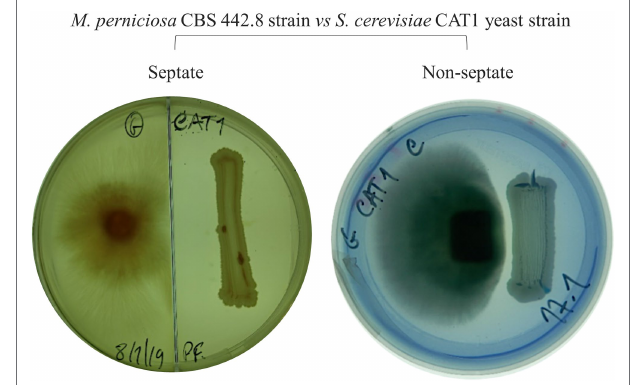
FIGURE 2 | Example of an antagonism assay in septate (left) and in regular (right) MEA plate incubated at 30 ° C for 7 days. The inhibition of Moniliophthora perniciosa is not observed in the septate plate.